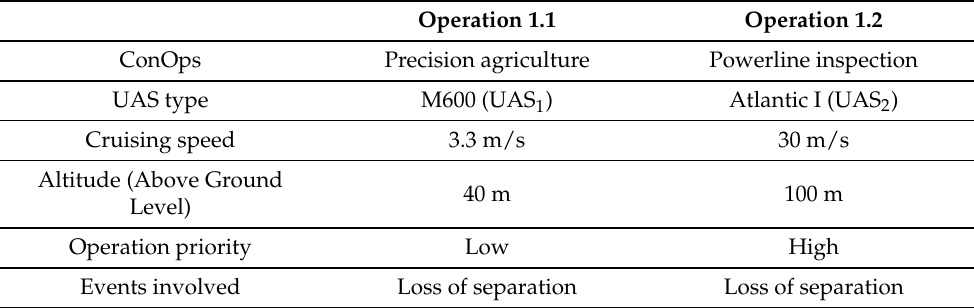
Figure 11. Top views including the initial flight plans of the use case 1 ( left ) and the use case 2 ( right ). All the operations were planned in an area of the Loring aerodrome in Madrid (Spain). Table 5. Operational parameters for the use case 1.